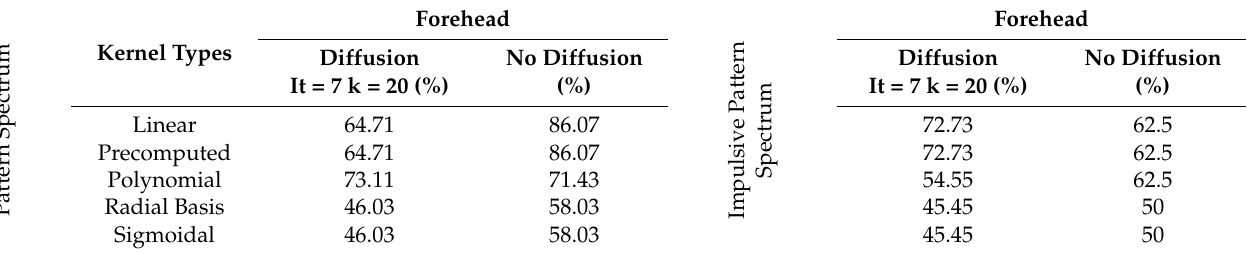
Table 3. Drunk person identification results using the isothermal of forehead region and feature vectors both the pattern spectrum and the impulse pattern spectrum for various kernel types. The best performance is obtained in case of pattern spectrum without